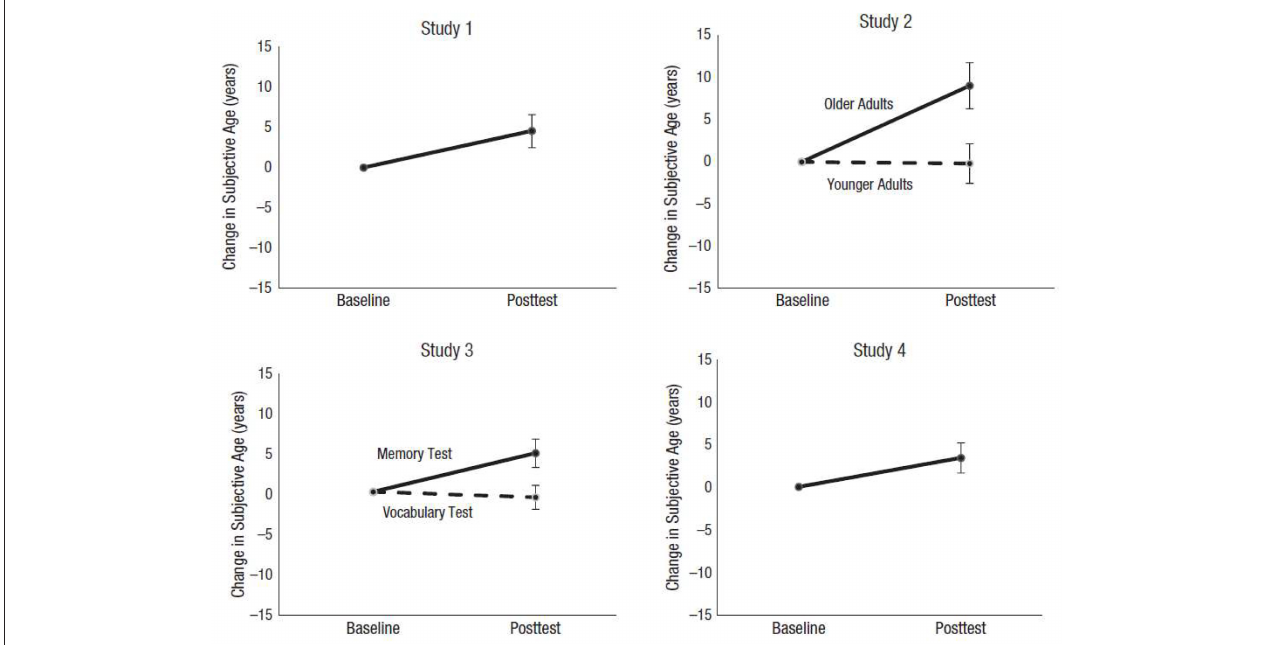
FIGURE 2 | Aging 5 years in 5 min. Results from Hughes et al. (50). Baseline subjective age was centered at zero for each study, and post-test subjective age is plotted as the difference from baseline after a memory test or vocabulary test. In Study 4, older adults were given instructions for a memory test, but reported their subjective age before taking the test. Error bars represent ± 1